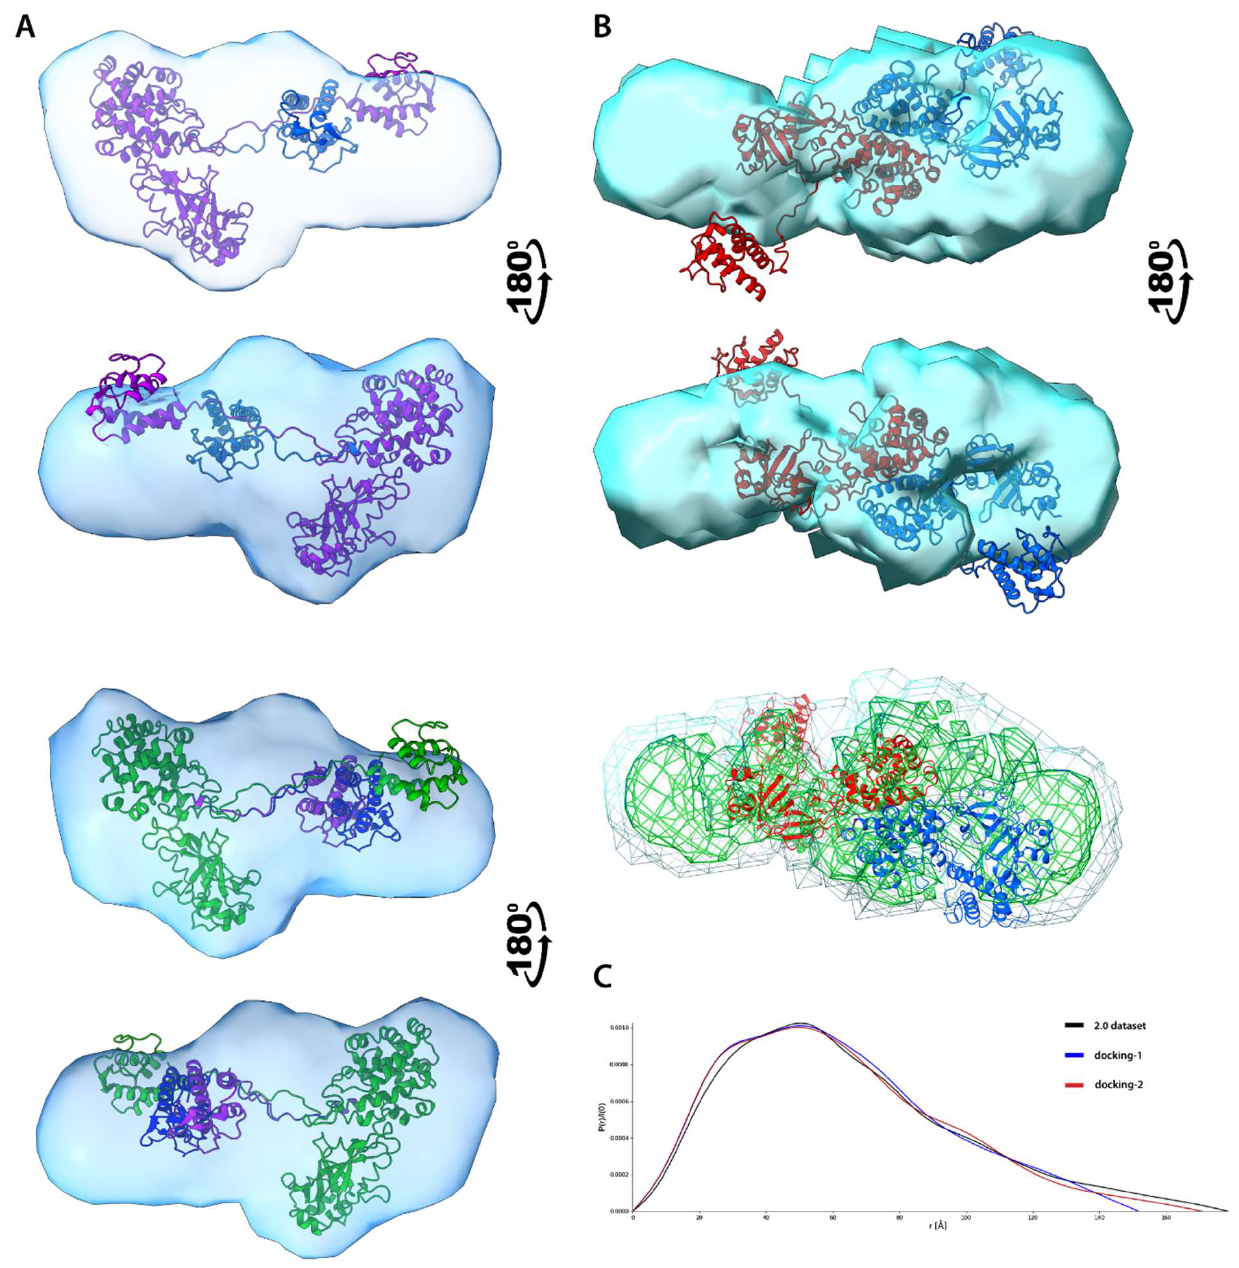
Figure 7. SAXS structural modelling of DT390-IL-13. ( A ) . Alignment of atomic models representing 2-state (top) and 3-state (bottom) models onto ED reconstruction. Each conformer is depicted using a different color. ( B ) . Alignment of atomic model of best-scoring dimer onto ED reconstruction, each monomer is depicted using a different color (top). Layers of different electron density showing coverage of polypeptide chain (bottom). ( C ). P(r) functions for both original and 2.0 dataset (representing a dimer)and two selected dimers created by the FoXSDock.